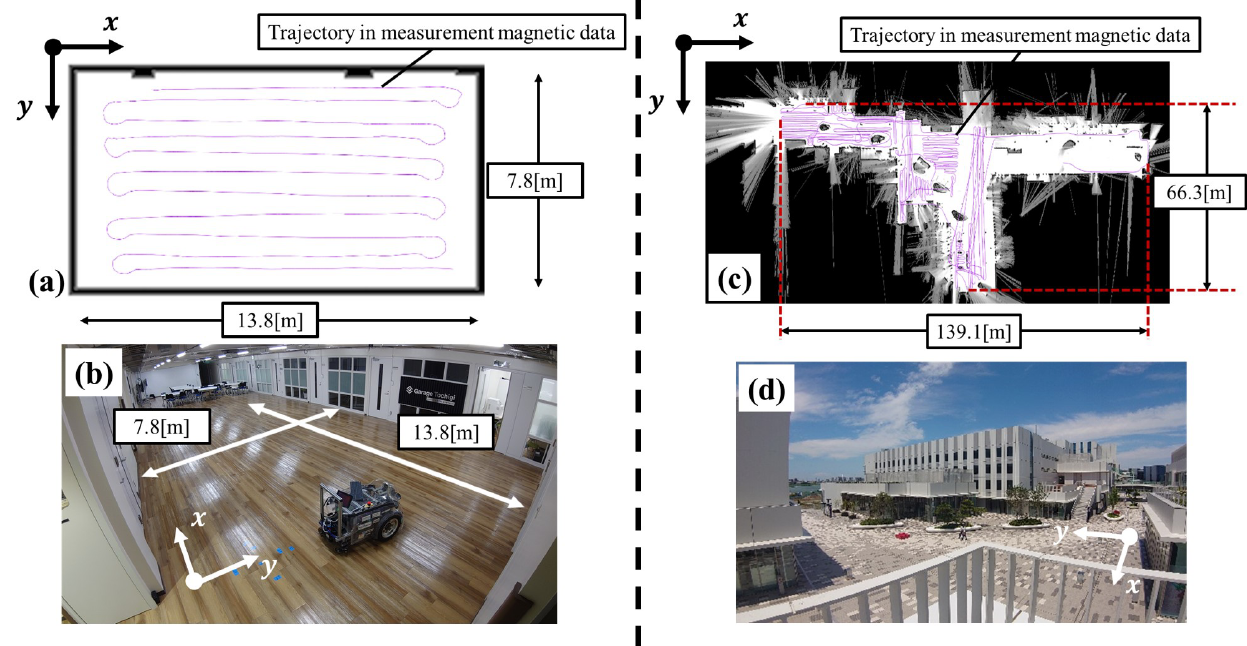
Figure 4. “REAL” and “HICity”, environments used in this experiment. ( a , c ) show the geometric map and the trajectory of the robot; when it measures magnetic information it is superimposed with a purple line. ( b , d ) show the environment in this